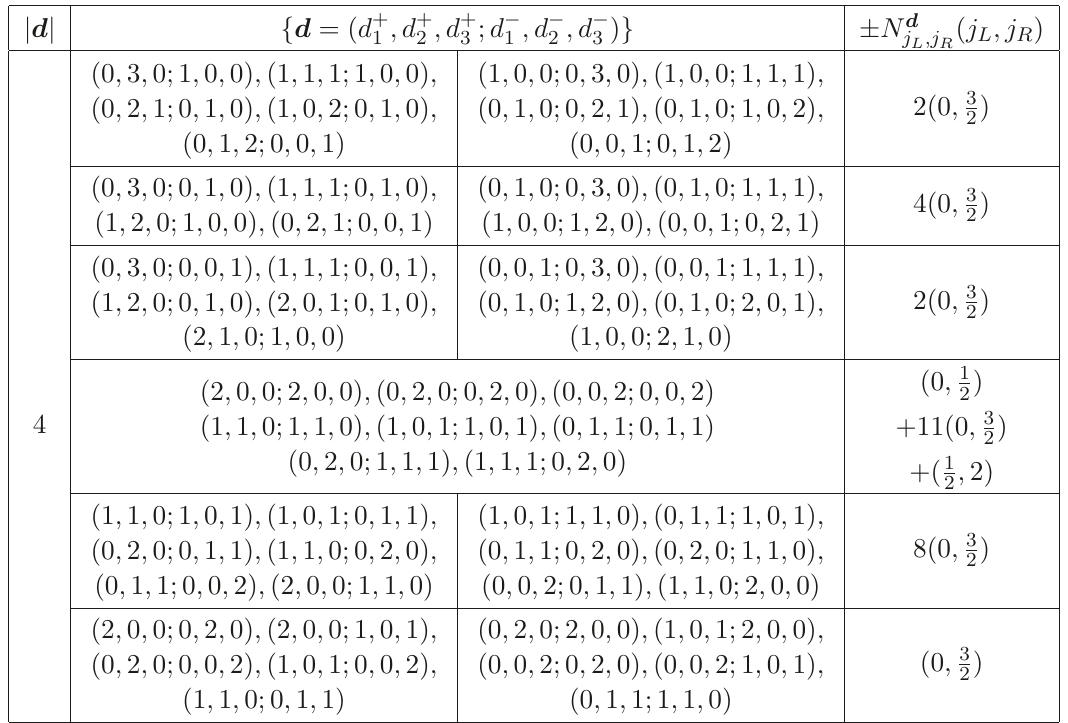
Table 3 . The conjectured BPS indices N d an additional assumption of exchanging T ± 1 and T ± 3 . Here column stands for the abbreviation of (